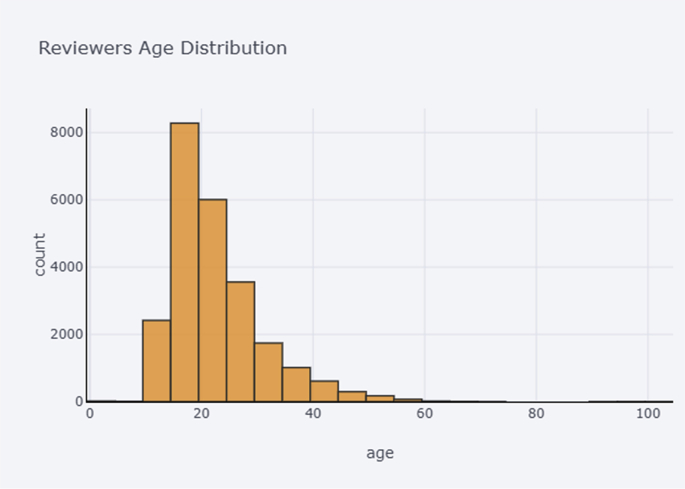
Age distribution.